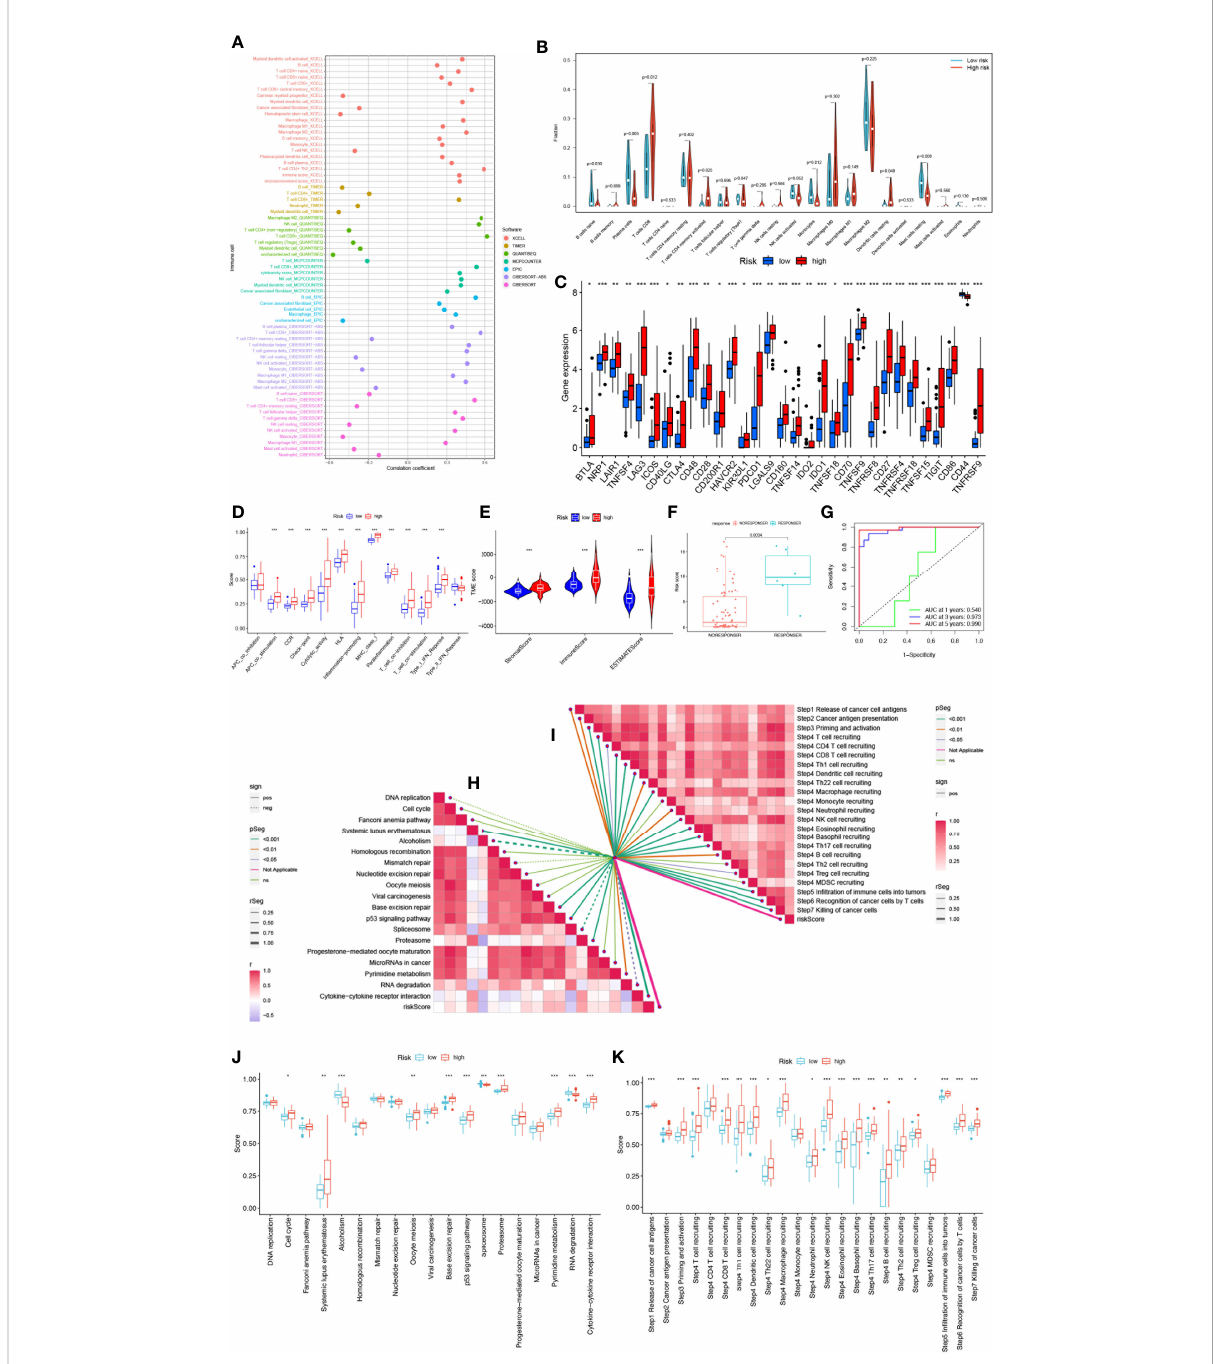
FIGURE 7 SMGs risk score predicts TME and immune cell in fi ltration. (A) Immune cell bubble map. (B) Differences in immune cell in fi ltration between high- and low-risk groups. (C) Immune checkpoint differences between high and low risk groups. (D) Immune cell and immune function ssGSEA scores between high- and low-risk groups. (E) The TME component analysis. (F) 4-SMGs predict immunotherapy response outcomes in patients. (G) Excellent predictive performance of ROC curve labeling model (H) Correlation between risk score and ICB response signature. (I) Correlation of risk scores with each step of the tumor immune cycle. (J) The plot of the difference in enrichment scores between the high- risk and low-risk groups on the immunotherapy prediction pathway. (K) The plot of differences between the high-risk and low-risk groups on each step of the cancer-immune cycle. * P < 0.05; ** P < 0.01; *** P <